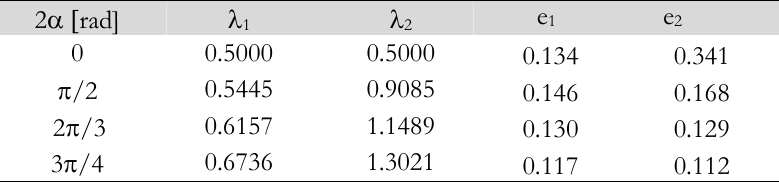
Tabella 1: Valori dei parametri presenti nell’equazione (2); e 1 ed e 2 ottenuti in ipotesi di deformazione piana utilizzando l’ipotesi di